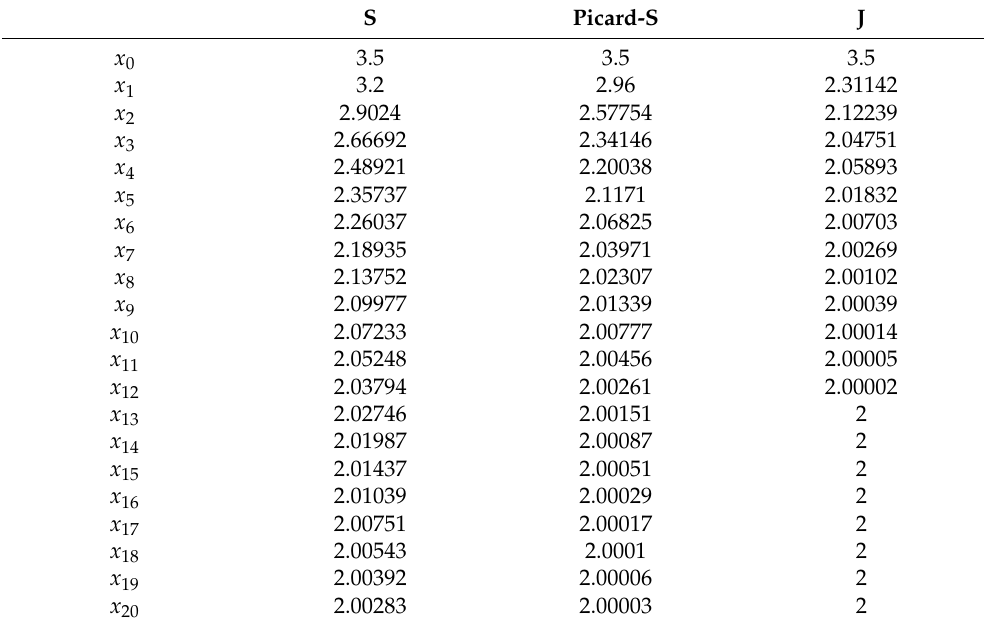
Table 1. Sequence formed by J, Picard-S, and S Iteration methods, having initial value x 0 = 3.5 for contraction mapping Q of Example 1.